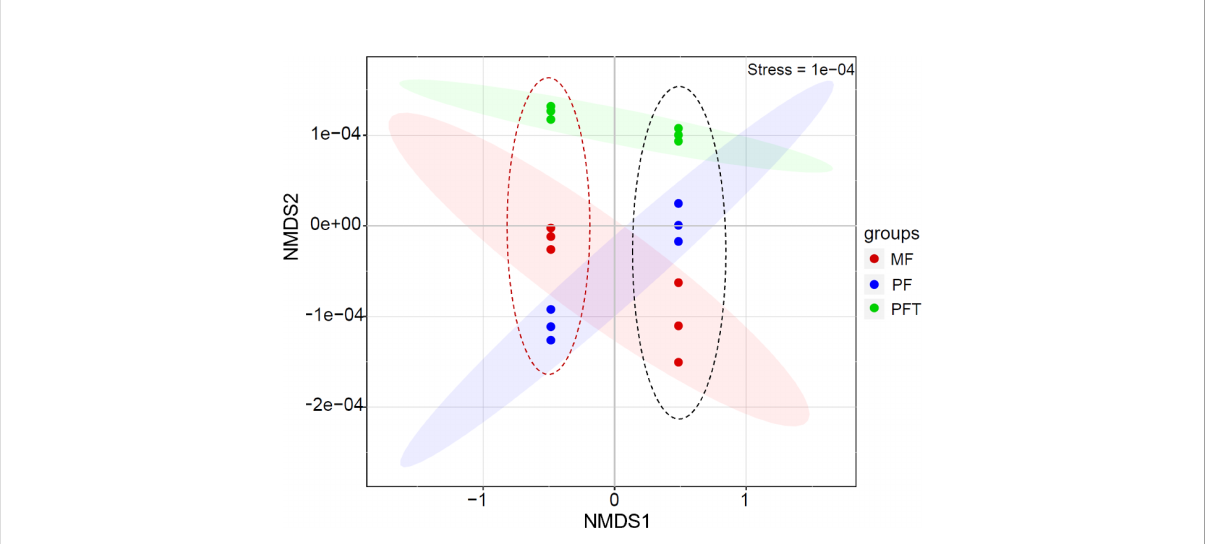
FIGURE 5 Non-metric multidimensional scaling (NMDS) based on Beta diversity dissimilarity among bacterial communities of the water sample (red dotted line on the left) and intestine (black dotted line on the right) of S. pharaonis from mysids feeding period (MF, red dots), the mid-feed transition period (FT, green dots), and the post-feed transition period (PFT, blue